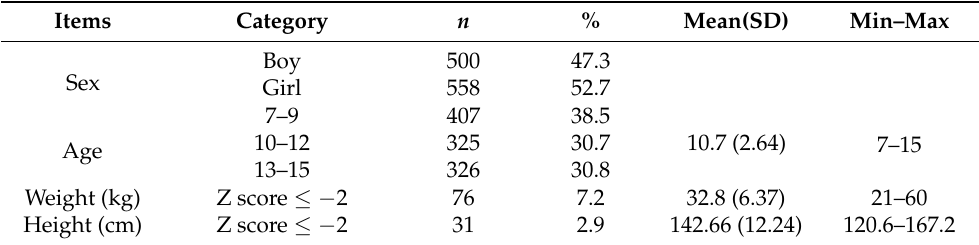
Table 1. General characteristics of participants ( n =